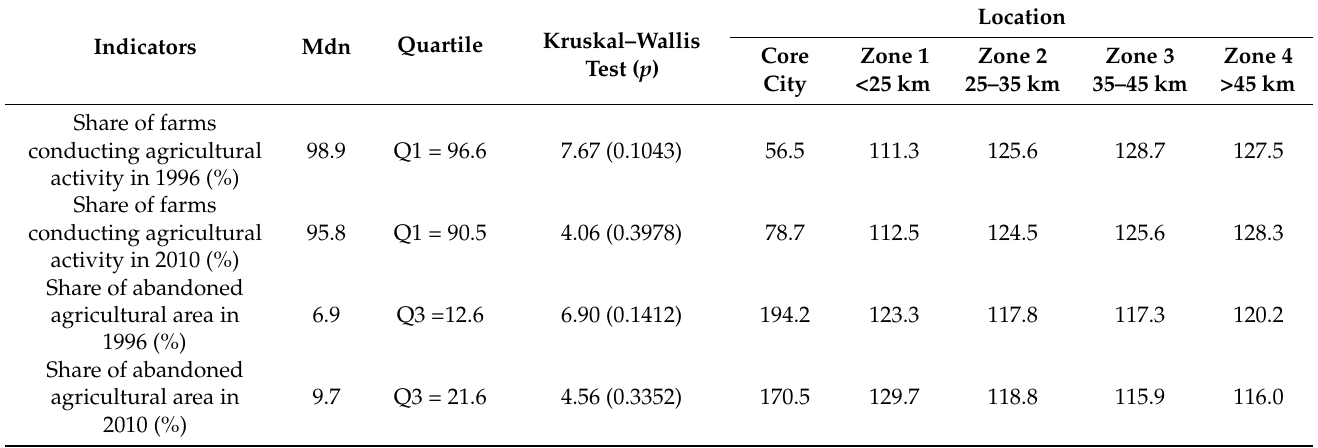
Table 10. Median, quartile, and medium rank size of selected variables building factor F6, depending on the location.